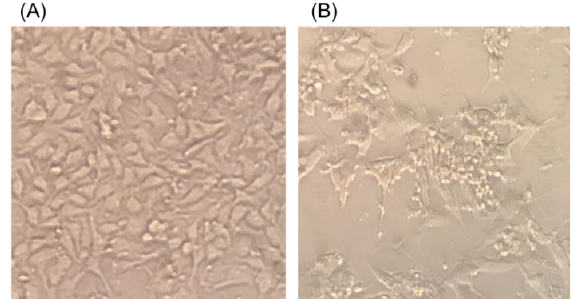
T Morphology of uninfected CPK cells ( A ) and 72 h after infection ( B ) with PAdV-5/WB/Ino5/2020/JPN at eighth passages ( ×